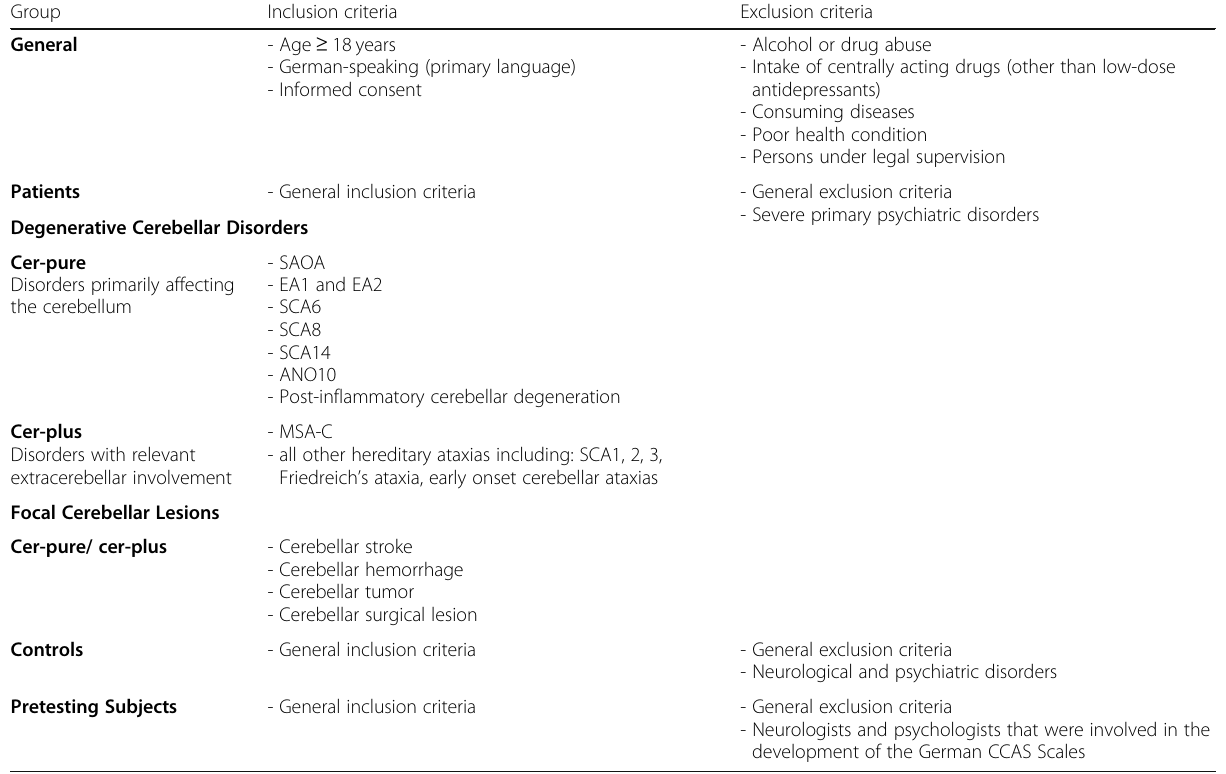
Table 1 Inclusion and exclusion criteria for patient and control selection Group Inclusion